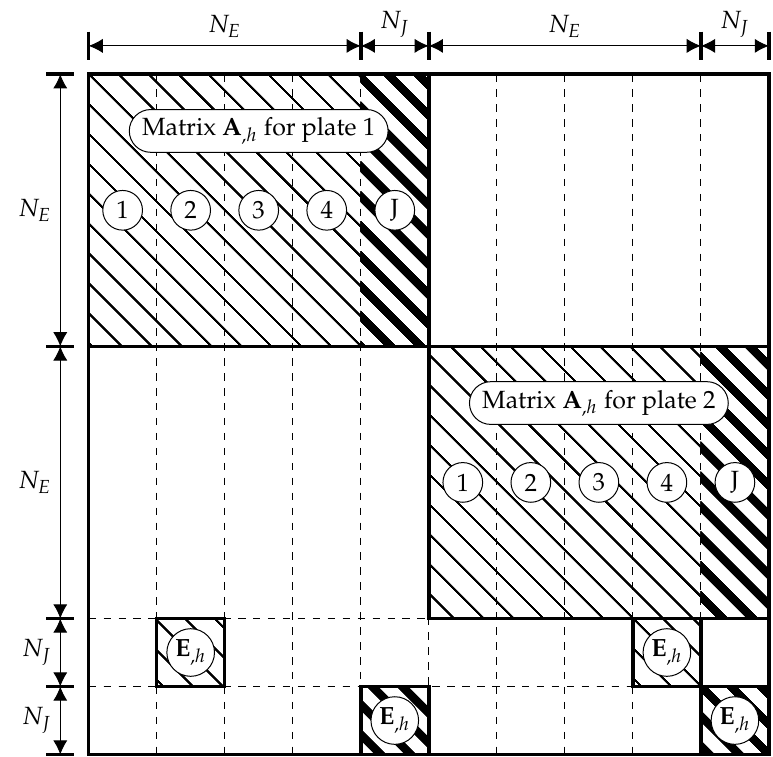
Figure 6. The A , h matrix for the assembled plate structure in Figure